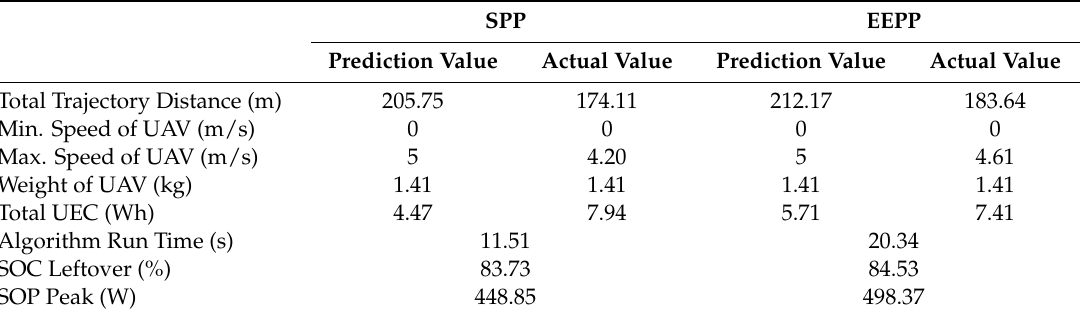
Table 4. Energy consumption comparison (experiment).